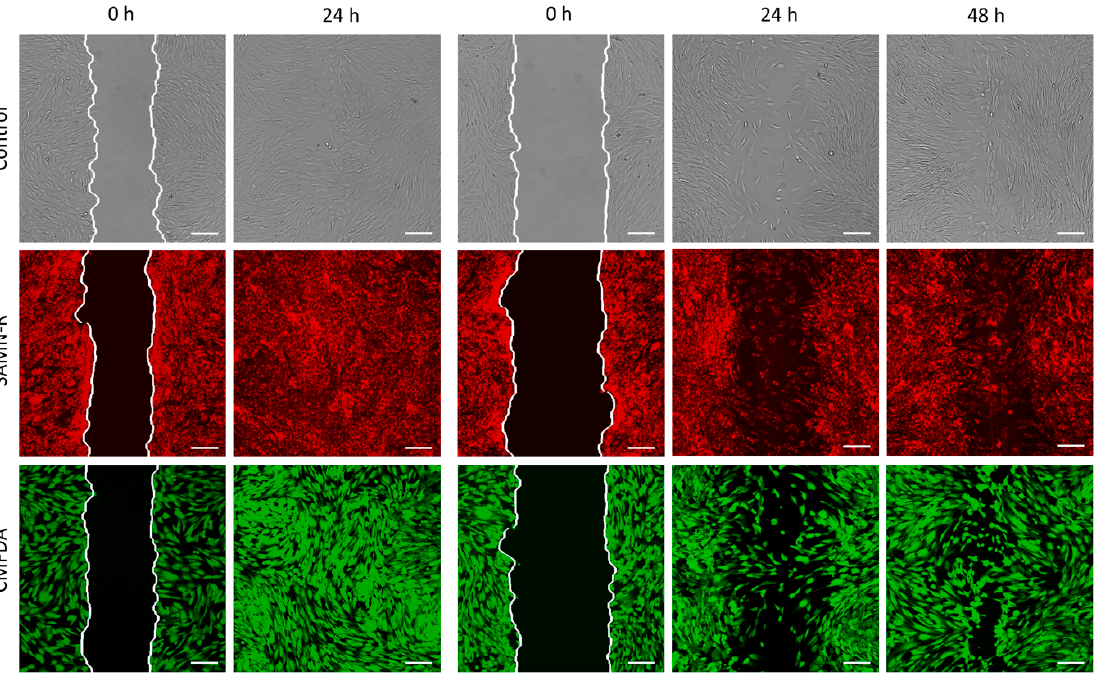
Figure 6. Wound healing assay applied to 3T3 cells: control, SAMN-R, and CellTracker™ Green CMFDA (5-chloromethylfluorescein diacetate) labelled cells. Images were detected at the beginning and after 24 and 48 hours. The white line marks the initial scratch border. Confocal microscopy, 10× magnification, scale bar 150 µm.